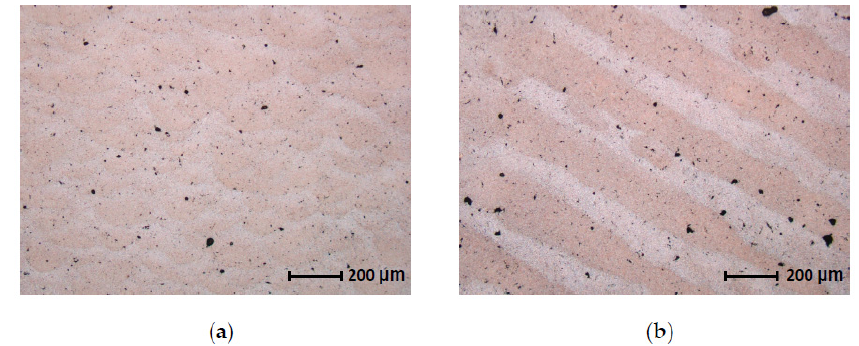
Figure 12. Sample 7-1: ( a ) longitudinal-L section; ( b ) transverse-T section.